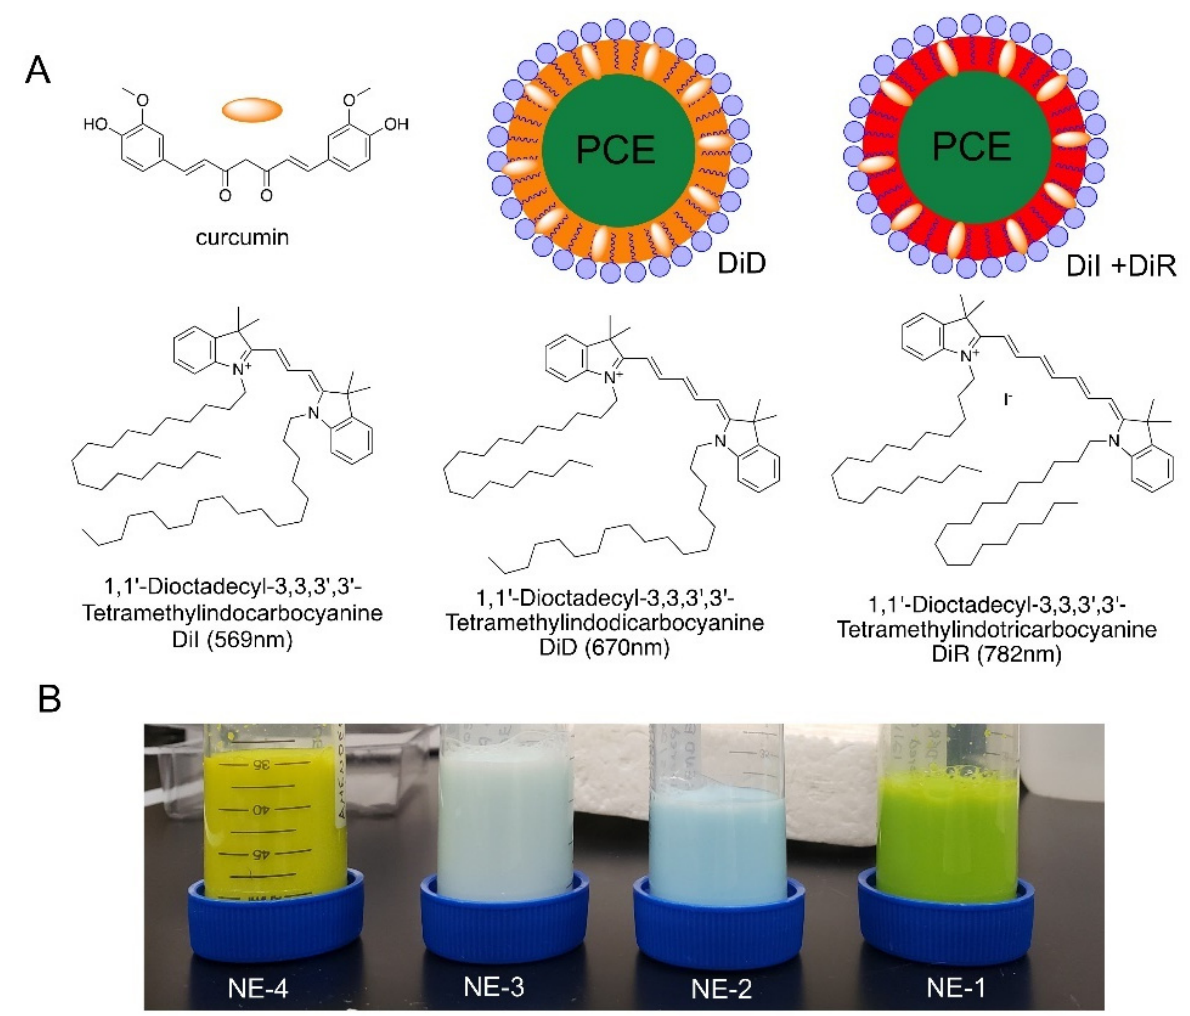
Figure 5. ( A ) Schematic of two-color PCE curcumin nanoemulsions. Curcumin and fluorescent dyes (DiD, DiR, and/or DiI) are incorporated into the hydrocarbon oil, which forms a corona that surrounds the PCE core. Non-ionic surfactants stabilize the hydrocarbon–water interface. ( B ) Image highlights the impact of curcumin and fluorescent dye on nanoemulsion color. From left to right: NE-4 (+CUR, +DiR); NE-3 (-CUR, +DiR); NE-2 (-CUR, +DiD); and NE-1 (+CUR, +DiD). NE-1 is a vibrant green color, while NE-4 maintains curcumin’s strong yellow color. This suggests a potential interaction between DiD and curcumin.